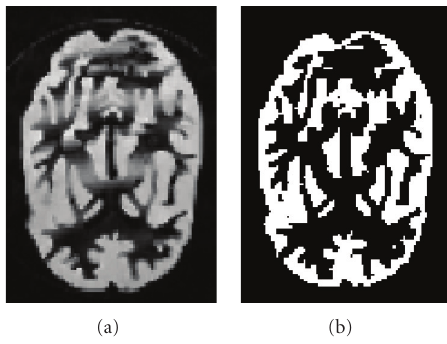
Figure 6: Example of segmentation for phantom. (a) Original MRI. (b) Segmented